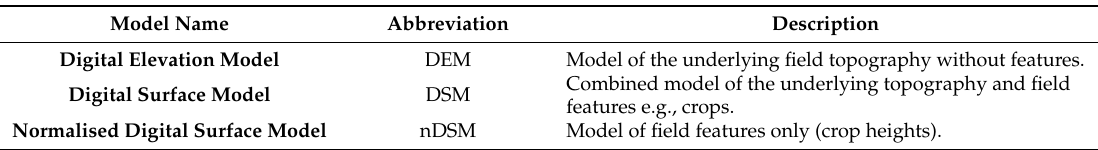
Figure 4. Visual representation of the Digital Surface Model (DSM), normalised Digital Surface Model (nDSM) and Digital Elevation Model (DEM). Table 5. Definitions of types of models generated in this study, based on definitions offered by Granshaw [42].